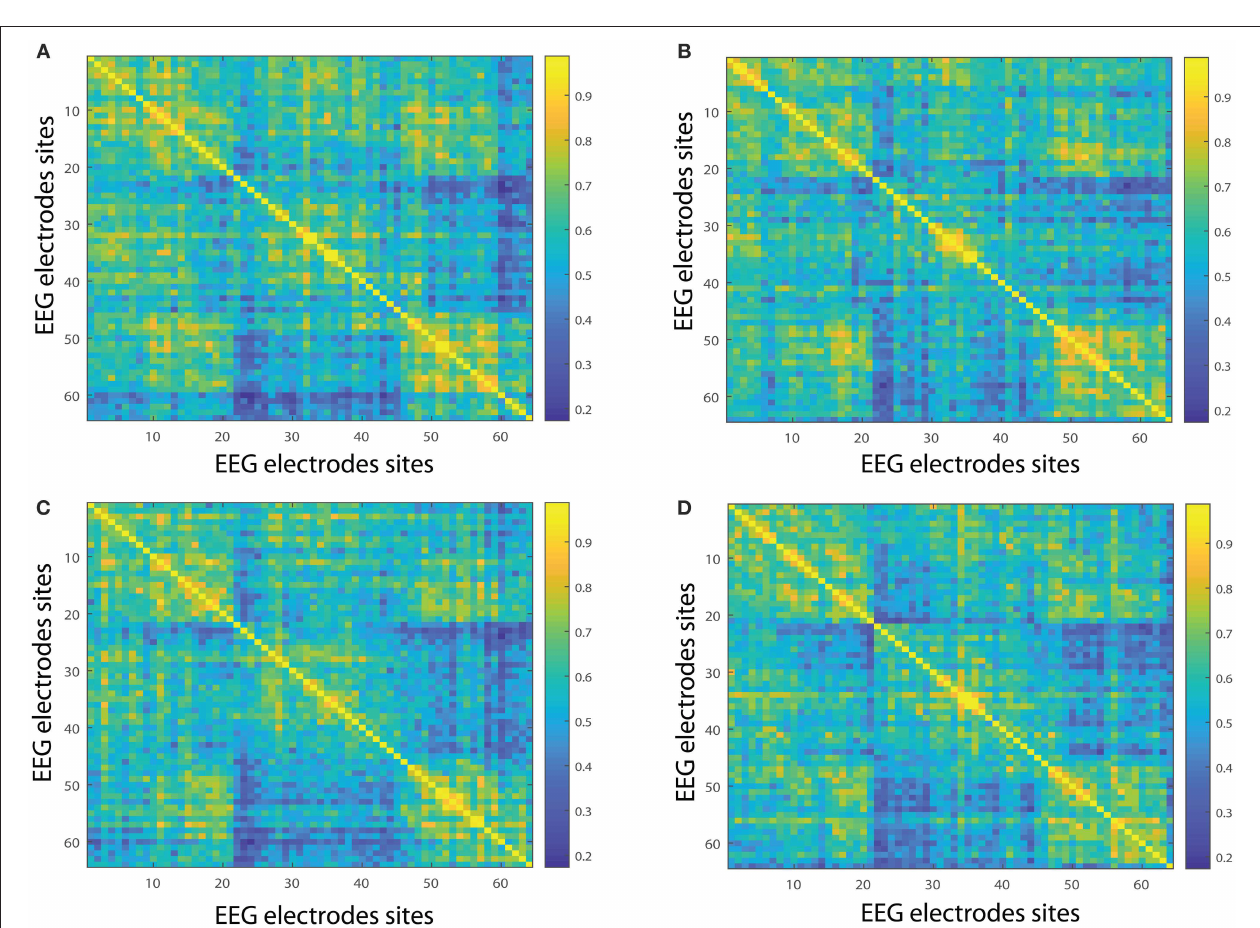
FIGURE 5 | Network interconnectivity. (A,B) Show the network averaged values of the interconnectivity considering 109 subjects when performing the visuomotor task for the 64-channel EEG considering the different oscillation bands alpha 1 and alpha 2. (C,D) Are the same as (A,B) but considering the imagined task. We consider D = 6 and τ = 1. Gamma 1 oscillation band corresponds to [31,41) Hz and gamma 2 oscillation band to [41,50) Hz .